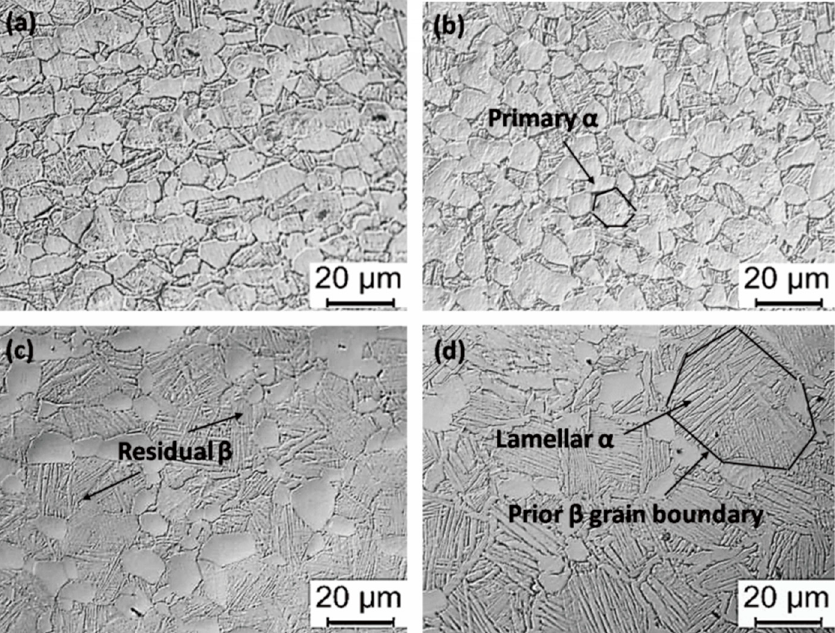
Figure 3. Metallographic image of microstructure obtained by different solution treatments ( a ) 920 °C × 1 h, AC; ( b ) 940 °C × 1 h, AC; ( c ) 960 °C × 1 h, AC; and ( d ) 980 °C × 1 h, AC.